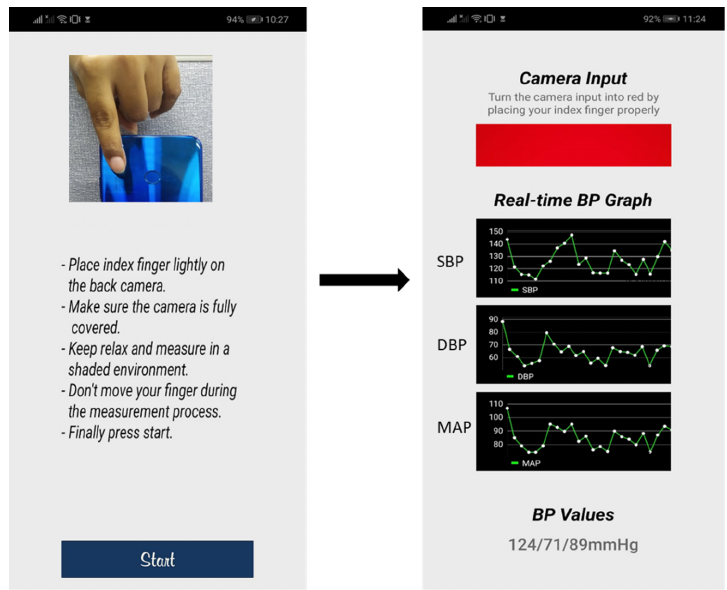
Figure 10. Real-time BP measurement using mHealth application.